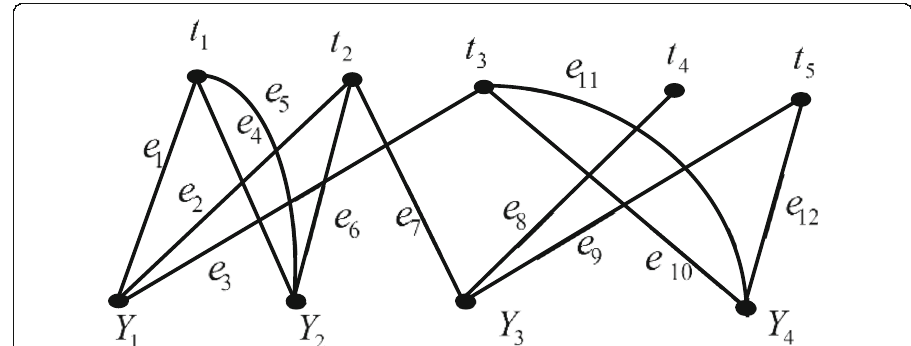
Fig. 4 The graph corresponding to the time table